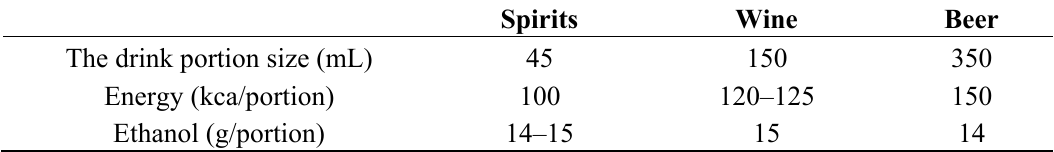
Table 5. Energy content and ethanol in alcoholic beverages [61].